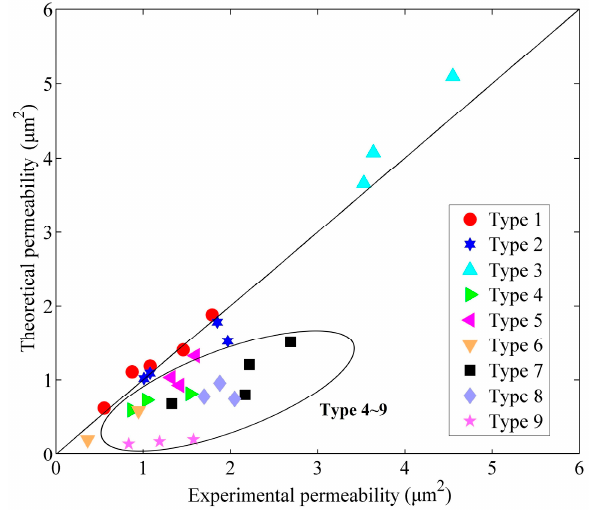
Figure 4. Experimental results of the permeability.